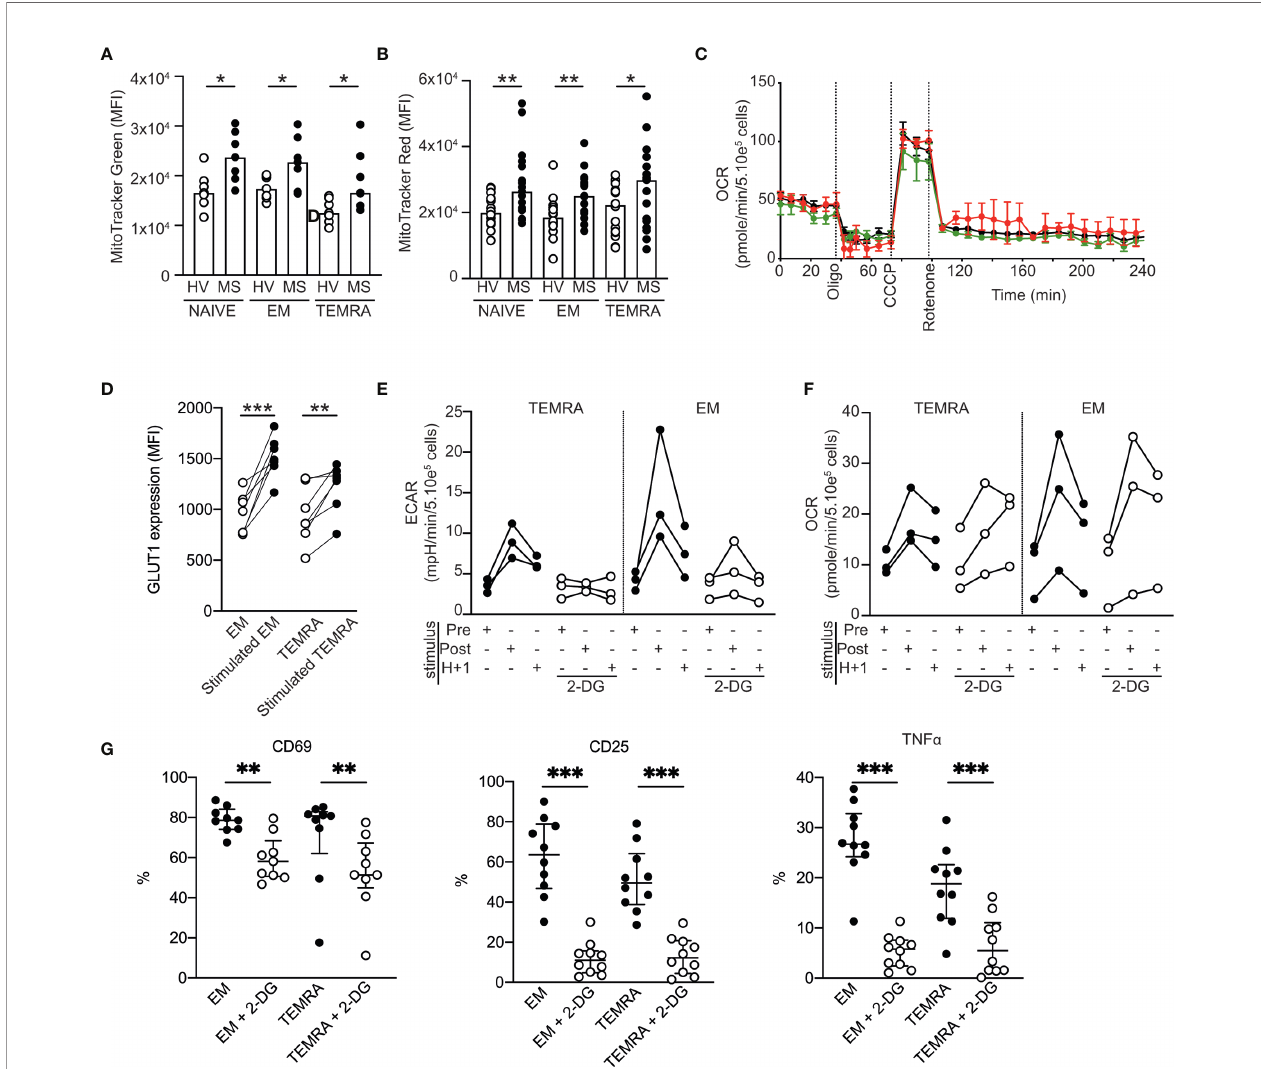
FIGURE 4 | Metabolic characterization of CD8 T cell subsets in patients with RRMS. (A, B) Mitochondrial load (A) and mitochondrial membrane potential (B) of CD8 T cell subsets of HVs and patients with RRMS assessed according to the mean fl uorescence intensity of MitoTracker green and red, respectively. (C) Oxygen consumption rate (OCR) of puri fi ed CD8 T cell subsets as measured by Seahorse technology before and after sequential addition of metabolic stress-inducing drugs. (D) Expression of GLUT-1 by EM and TEMRA CD8 T cells of patients with RRMS upon overnight stimulation with plate-bound anti-CD3. (E, F) Extracellular acidi fi cation rate [ECAR; (E) ] and OCR (F) of EM and TEMRA CD8 T cells of patients with RRMS before and after polyclonal stimulation in the absence or in the presence of the glycolysis inhibitor 2-DG. (G) Expression of activation markers (CD69 and CD25) and proin fl ammatory cytokines (TNF a ) in EM and TEMRA CD8 T cells of patients with RRMS after overnight stimulation with plate-bound anti-CD3 and IL-15 in the presence of medium control or 2DG. (A, B, D – G) Each dot represents a unique patient, and the median and interquartile ranges (IQRs) are shown. Signi fi cance was determined by unpaired Mann-Whitney U or paired Wilcoxon test (*p < 0.05; **p < 0.01; ***p < 0.001). (C) Representative OCR pro fi le from one out of 5 patients with